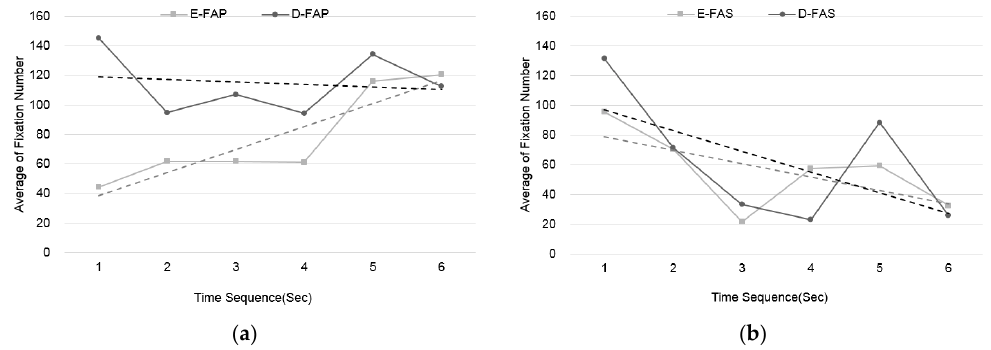
Figure 4. The average fixation periods for the AOIs according to the two groups. ( a ) Average fixation of AOI paths in the “easy” group (E-FAP) and the “difficult” group (D-FAP); average fixation gradually decreased along the “easy” group’s “path” but increased for the “difficult” group. ( b ) The average number of fixed appearances of the “sign” over time in E-FAS and D-FAS; the average fixation decreased similarly for E-FAS and D-FAS.